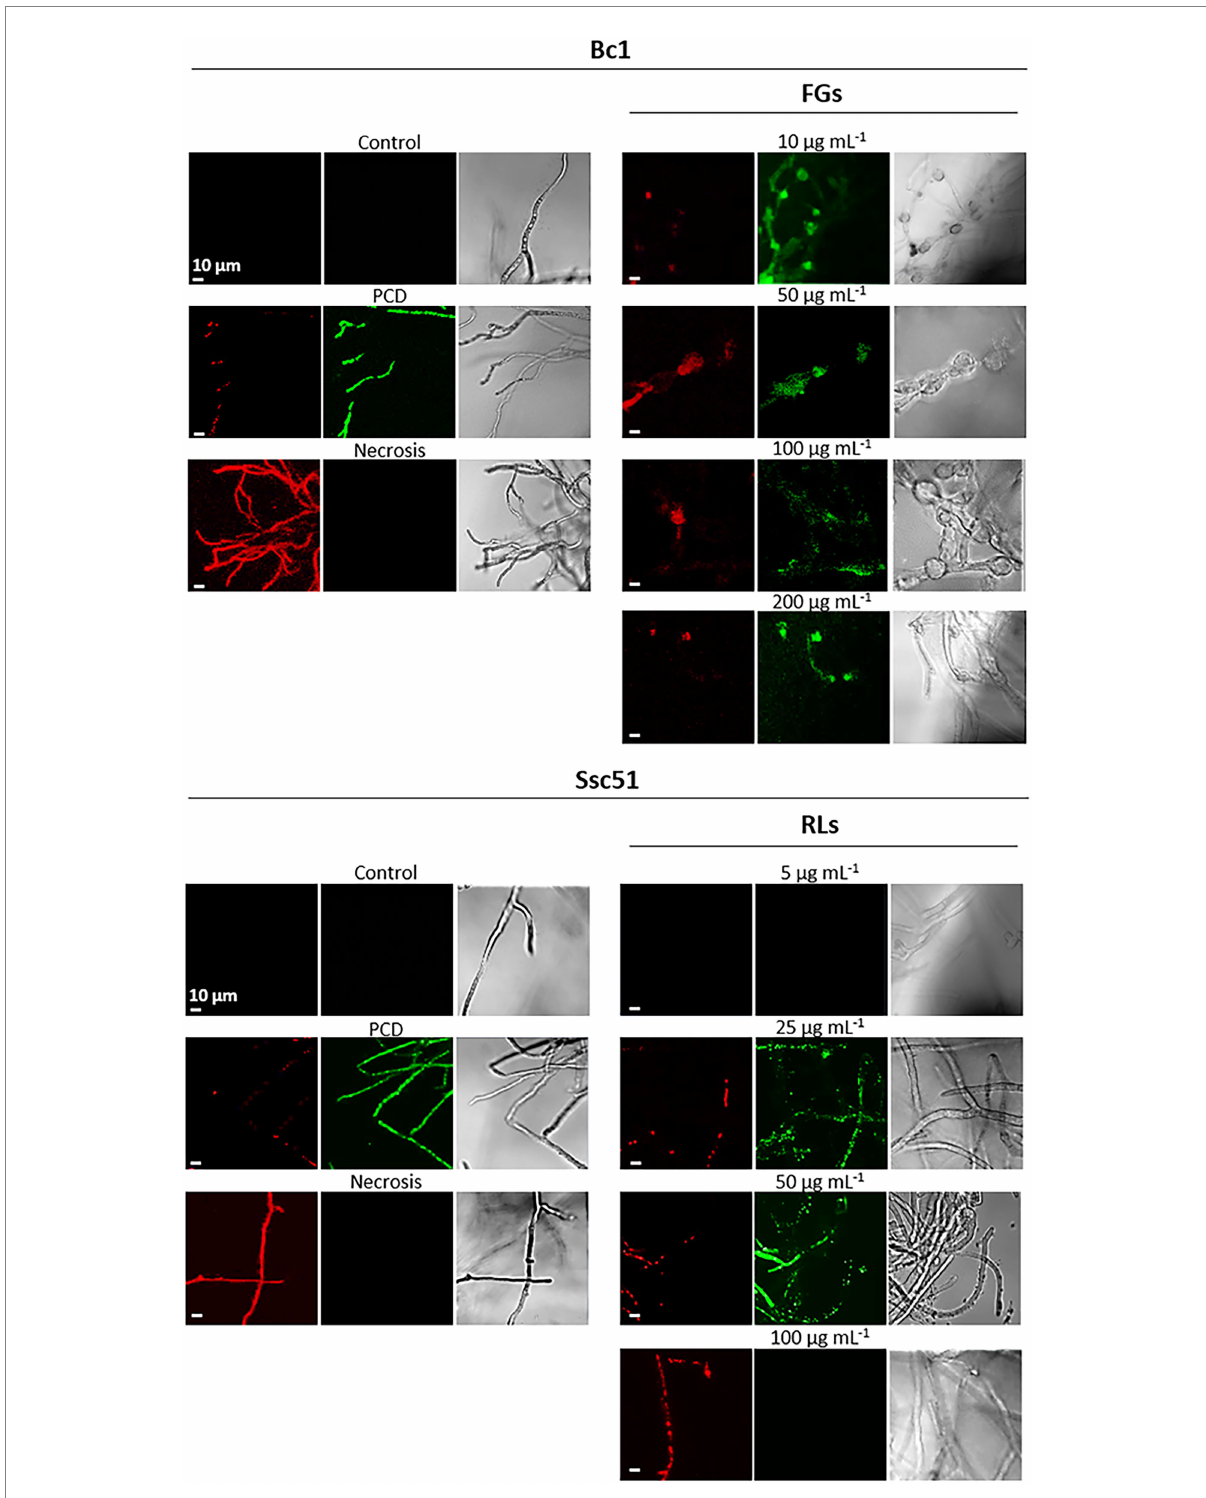
FIGURE 7 Cell death mechanisms after treatments with RLs or FGs. Confocal fluorescence microscopy observations of B. cinerea and S. sclerotiorum mycelium after treatments with different concentrations of RLs or FGs. PCD corresponds to mycelium treated with 3 mM hexanoic acid; necrosis corresponds to boiled mycelium. Cells were co-stained with propidium iodide (red) and Alexa Fluor ® 488 annexin V (green) to assess permeability and phosphatidylserine externalization, respectively. Left and middle panels are fluorescence microscopy images for propidium iodide and annexin V, right panels are light microscopy images. Scale bar: 10 μ